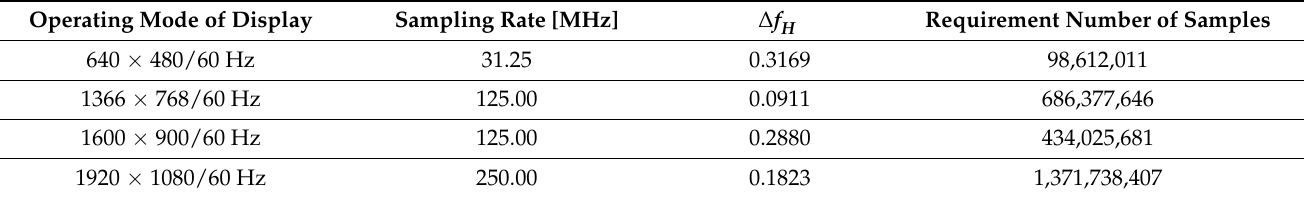
Table 5. Determination of the required number of samples for the